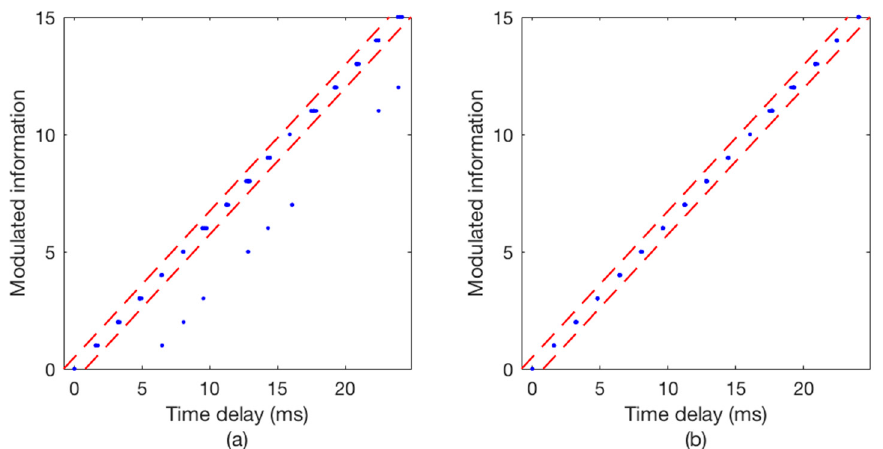
Figure 12. The decoding results of the corresponding data. ( a ) Without TRM; ( b ) with TRM.